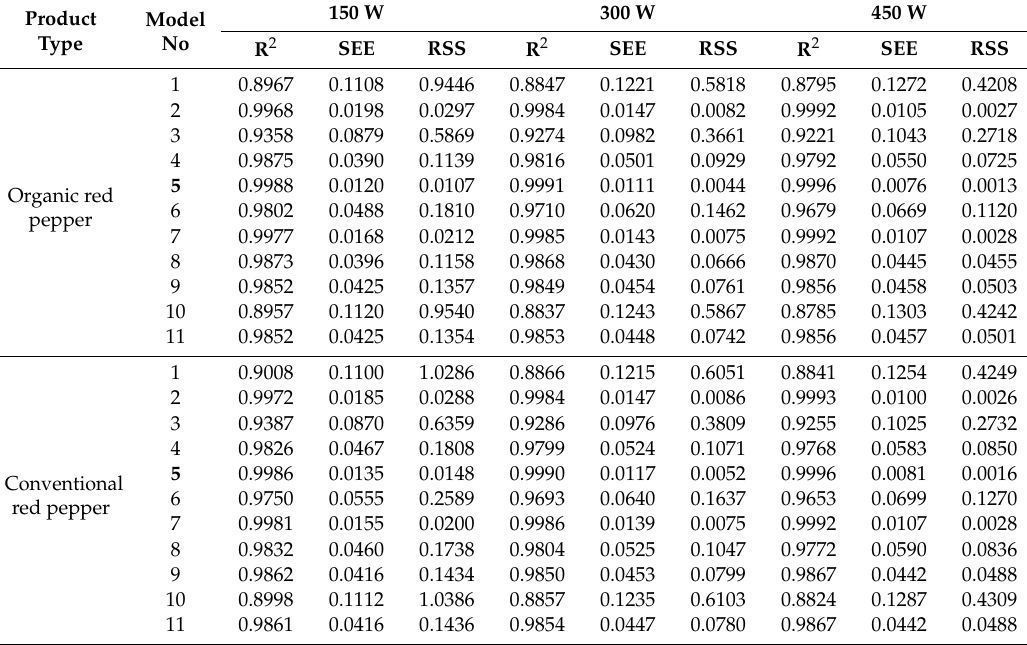
Table 4. Fitting ability of eleven drying models for the intermittent microwave drying of organic and conventional sweet red peppers.